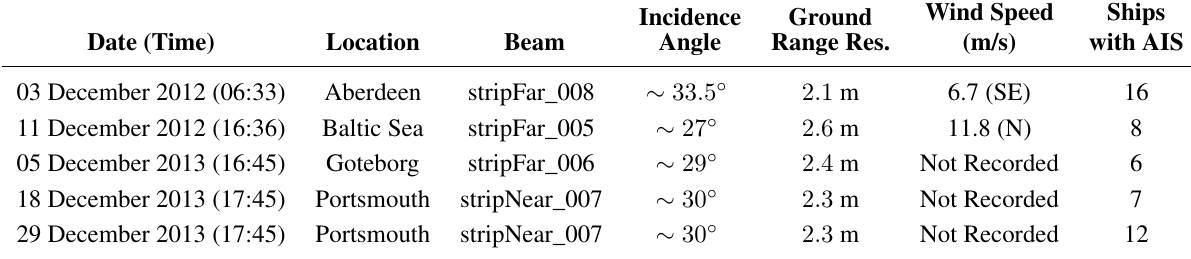
Table 4. Details on HH/VV TerraSAR-X images exploited in the comparison. Time is in